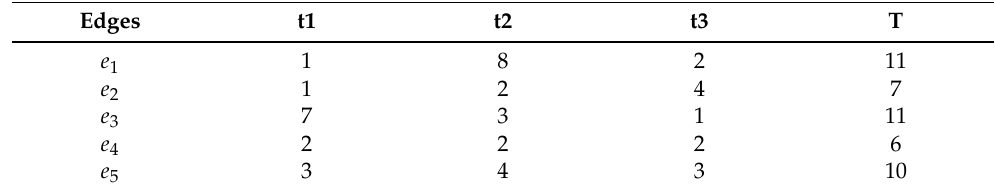
Figure 4. Algorithm example: communication graph constellation at three points in time (t1–t3) and the optimal spanning tree (T). Table 1. MST on a dynamic graph algorithm